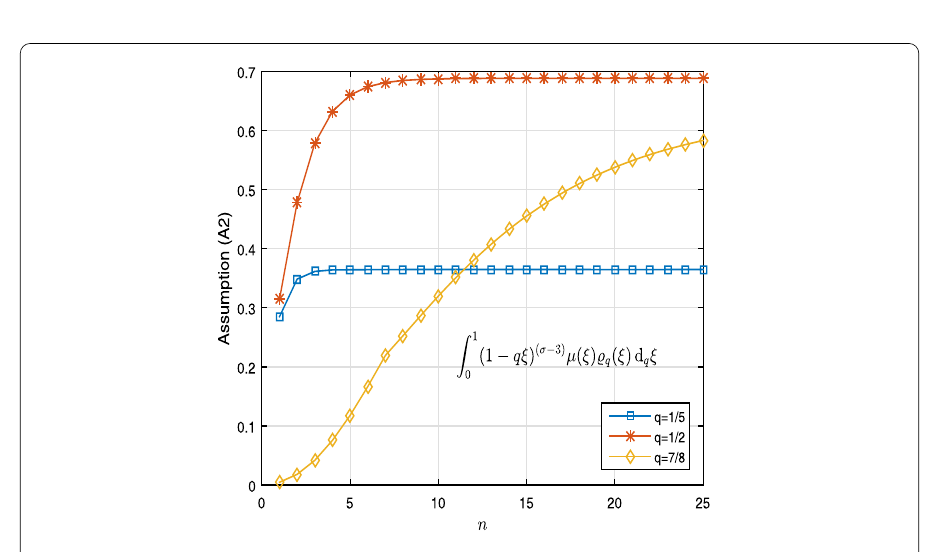
Figure 6 2D graphs of